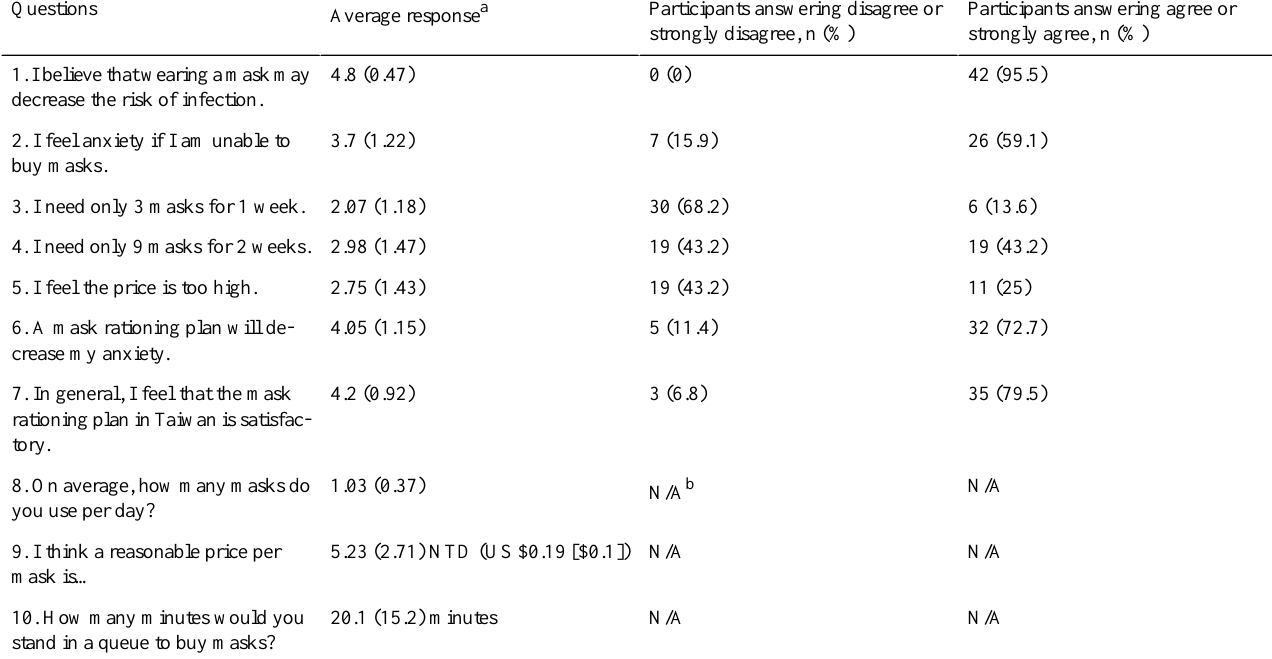
(%)Average response a Questions